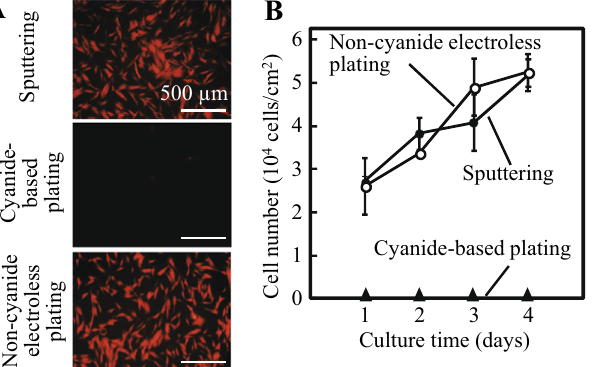
Figure 2. Cell adhesion and growth on gold-plated substrates. ( A ) Fluorescent images of RFP-HNDFs on gold substrates prepared by sputtering, cyanide electrolytic gold plating, and non-cyanide electroless gold plating at 1 d post-culture. ( B ) Proliferation of cells on different gold substrates. The error bars indicate standard deviations calculated from 3 independent experiments.